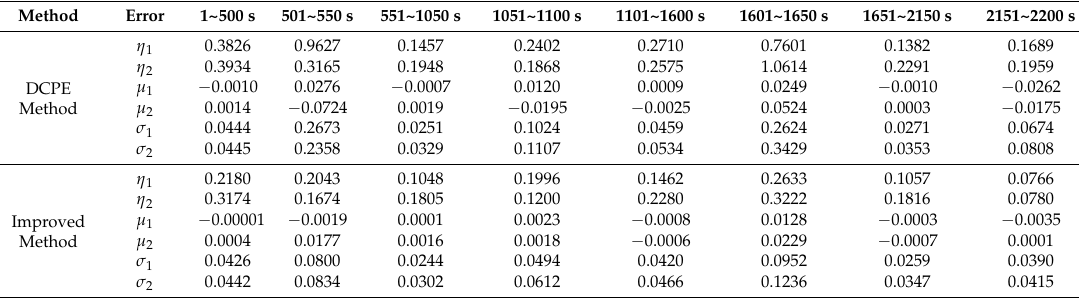
Table 2. Detailed errors during each parts of movement.